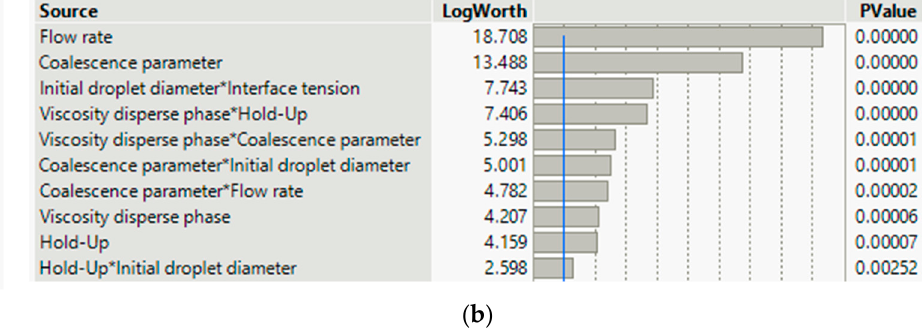
Figure 16. Illustration of the regression quality of the OLS regression ( a ) and parameter sensitivities of the MFAT simulations ( b ).